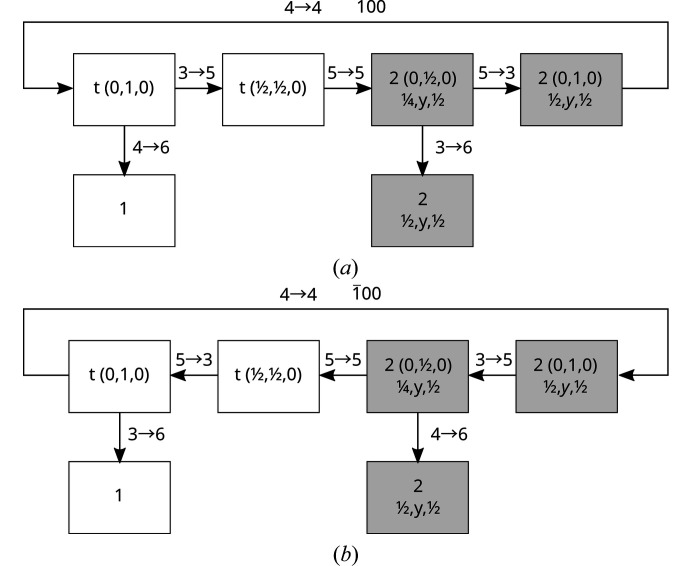
Directed quotient graphs of the hydrogen-bonding chains schematized in Fig. 10 ▸. Each node represents molecules and their equivalents by translation along n
a, . The orientations of molecules represented by white and gray nodes are related by a 2[010] rotation. Arrows represent hydrogen bonds and are labeled with the connected oxygen atoms. A voltage of 100 or  on top of an arrow means that the target node is related to the corresponding node in the 0 < x < 1 unit cell by the translation along a and −a, respectively.